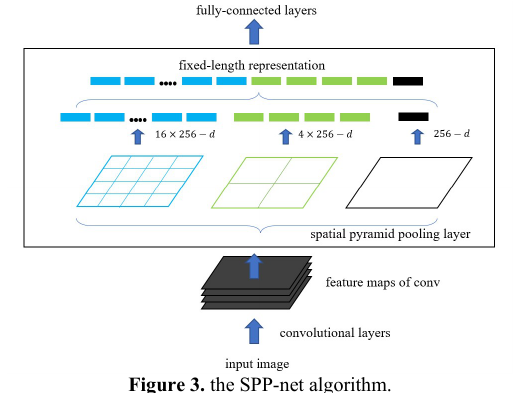
Figure 3. the SPP-net